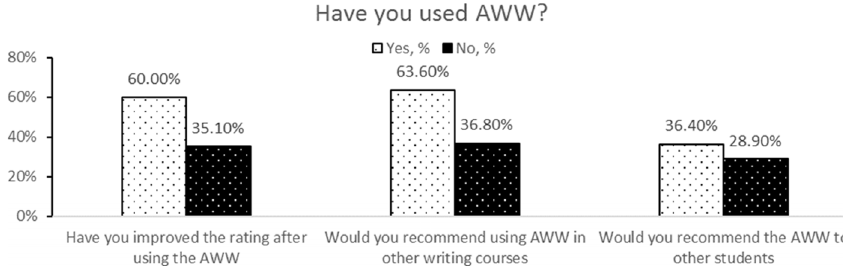
Fig. 7 Comparison of answers to questions regarding who used AWW and who did